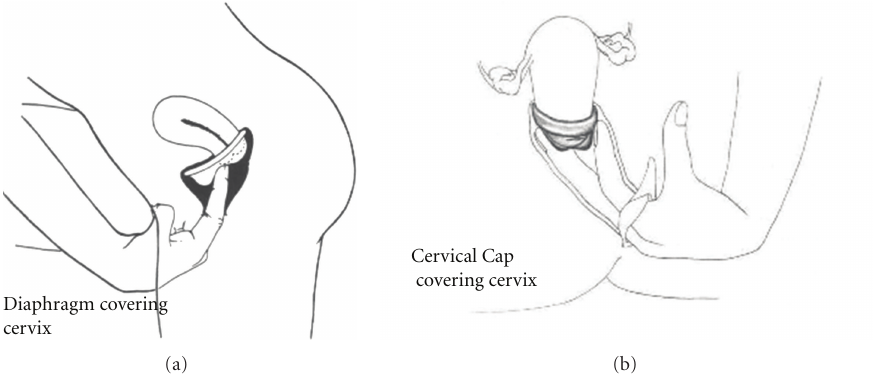
Figure 1: Diaphragm versus cervical cap placement. Courtesy of Rebecca Chalker, The Complete Cervical Cap Guide , copyright 1987.